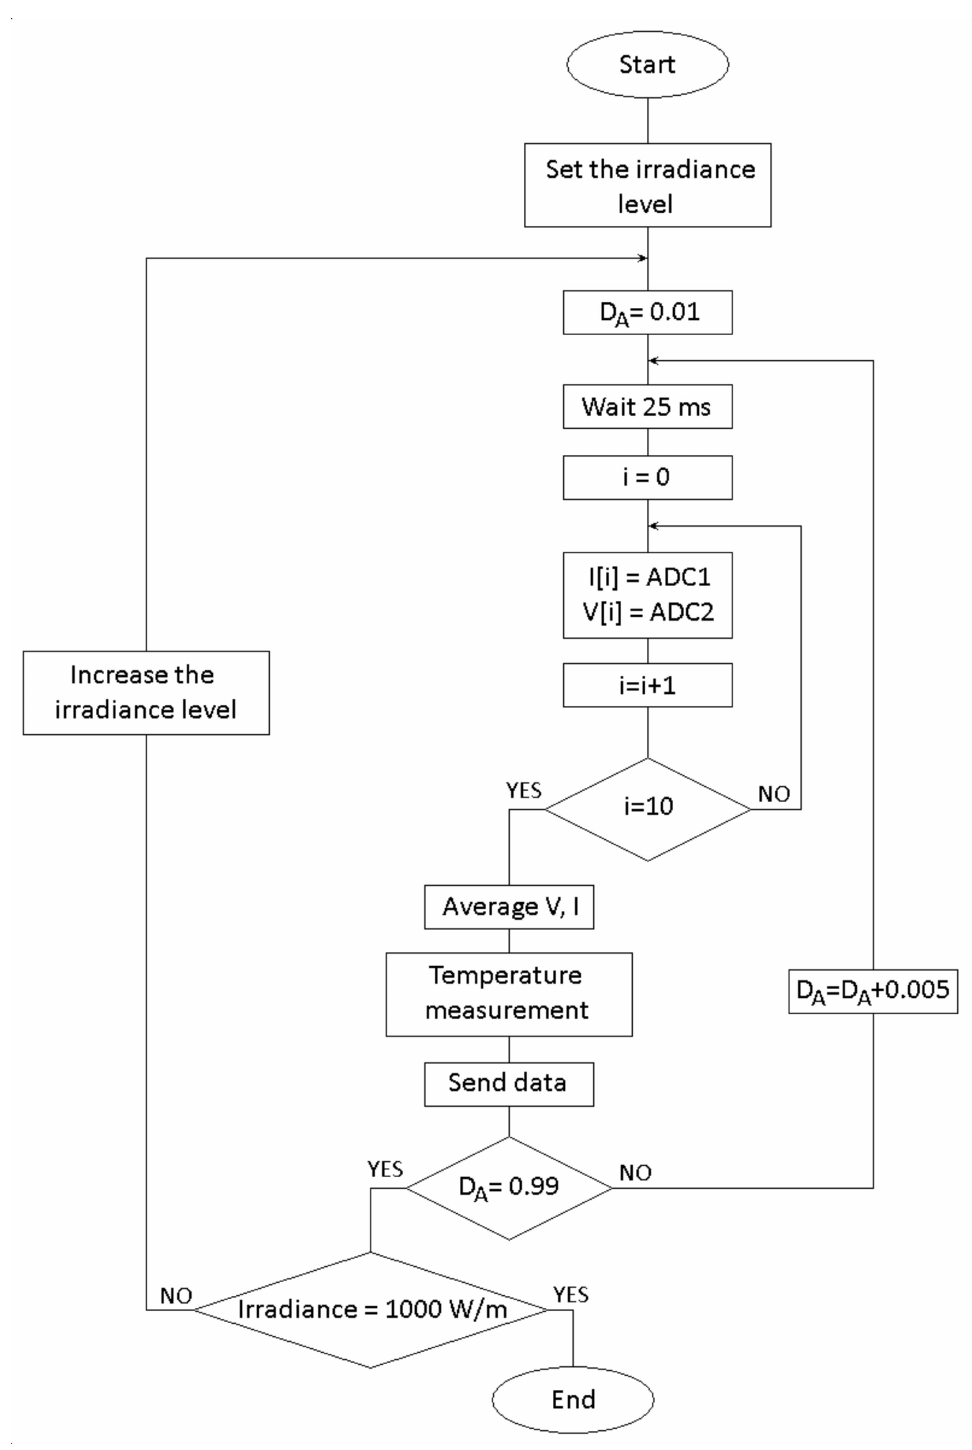
Figure 7. The algorithm for the